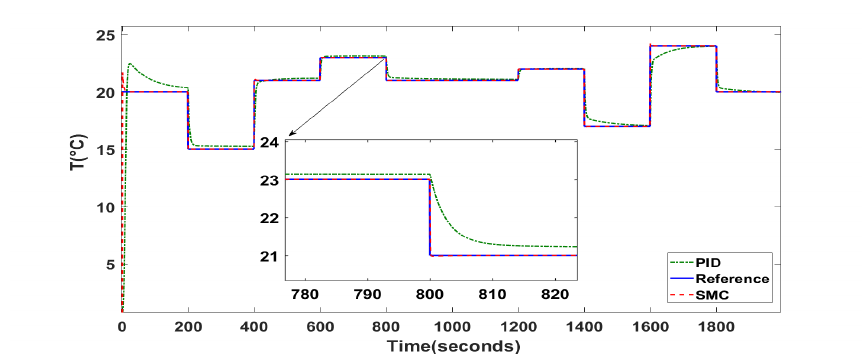
Figure 9. Tracking result of PID and SMC for the Zone 2 combination of steps reference.